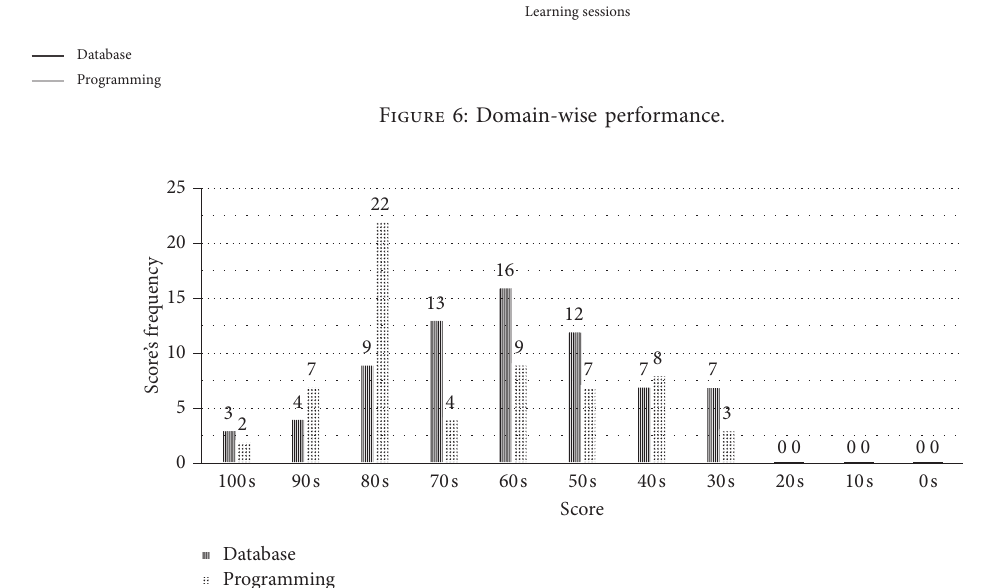
Figure 7: Student performance